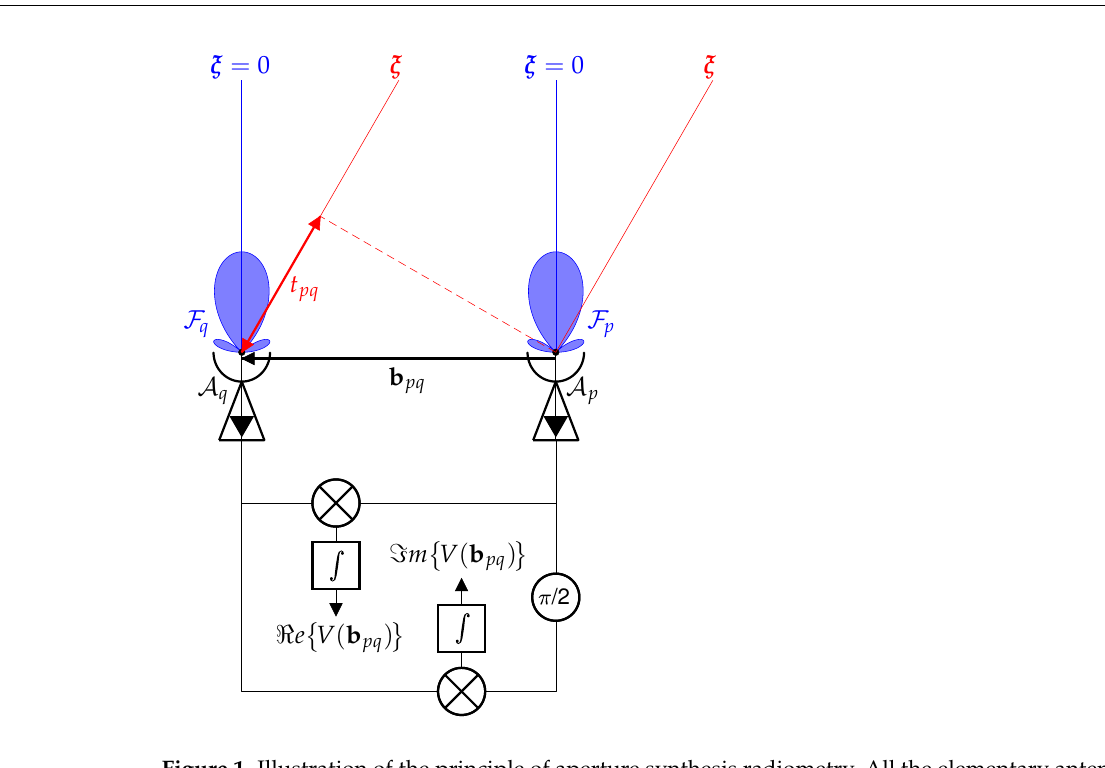
Figure 1. Illustration of the principle of aperture synthesis radiometry. All the elementary antennas of an interferometric array, here reduced to two antennas A p and A q separated by a baseline b pq , are pointing in the same direction, depicted here by the main beam of the elementary patterns F p and F q (in blue). The radio signal kept by each elementary antenna is coming from any direction ξ of the surrounding space. Referring to the integral in (1), the contribution from direction ξ (in red) depends on the delay t pq = ( b pq · ξ ) / c between the time a wave train (dashed red) arrives on antenna A p and its arrival on antenna A q . For the contribution from the nadir looking direction ξ = 0 (in blue), this delay is equal to zero. The two radio signals are transmitted to a complex correlation unit to be combined in-phase/in-quadrature and integrated in order to provide the real and imaginary parts of the complex visibility sample V for the baseline vector b pq . To make the illustration simpler without losing anything of the interpretation of Equation (1), amplifiers, local oscillators, and band-pass filters are intentionally omitted (more details can be found in